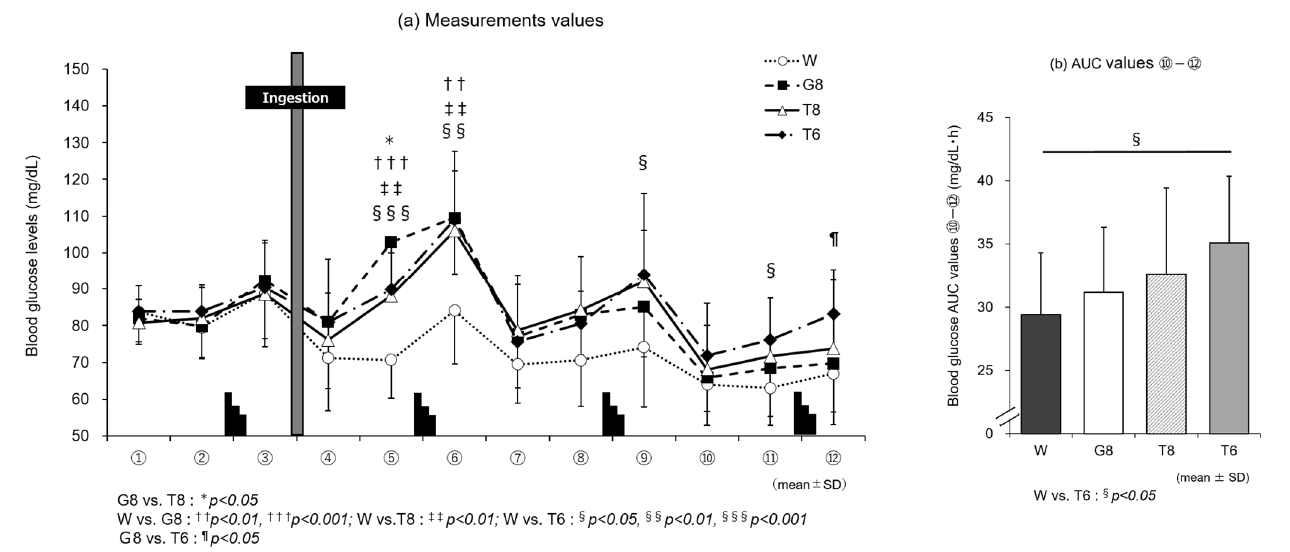
Figure 3. Changes in blood glucose levels with trial drinks (W, G8, T8, T6) (experiment 1). Compar- ison between ( a ) measurements and ( b ) area under the curve (AUC) ⑩ – ⑫ values of trial drinks ( n = 12). G 8 vs. T 8: * p < 0.05; W vs. G8 : †† p < 0.01, ††† p < 0.001; W vs. T8 : ‡‡ p < 0.01; W vs. T6 : § p < 0.05, §§ p < 0.01, §§§ p < 0.001; G8 vs. T6 : ¶ p < 0.05. W, water; G8, 8% glucose; T8, 8% trehalose; T6, 6% trehalose.